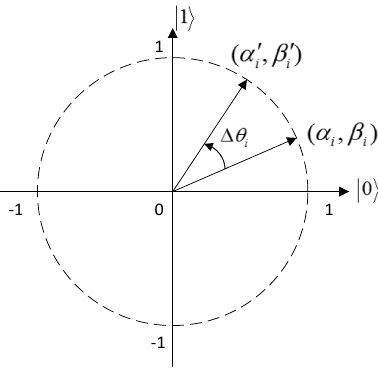
Figure 3. Polar plot of quantum rotation gate for qubit. Table 1. Lookup table of rotation